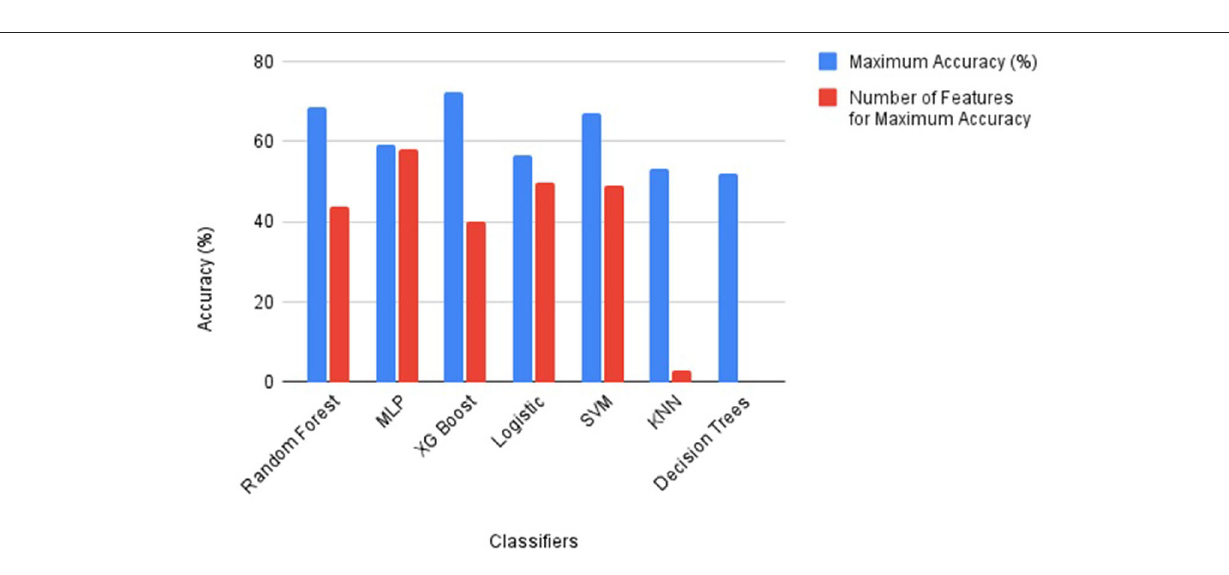
FIGURE 5 | Maximum accuracy for classification